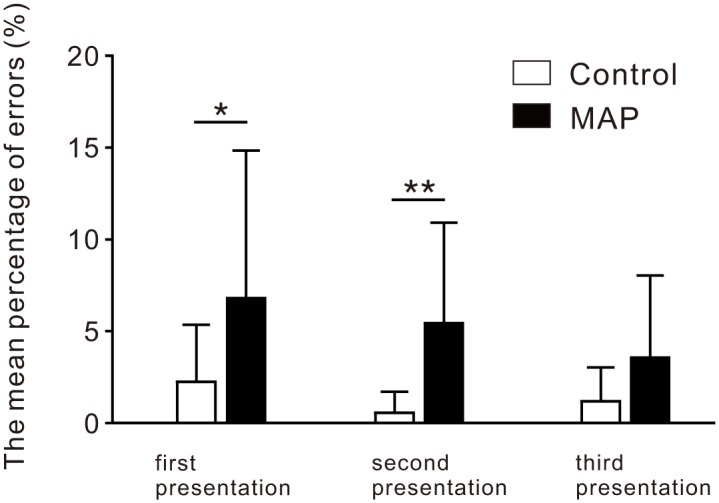
Mean percentage of errors during the incongruent Stroop color-word task.Comparison of mean percentage of errors between methamphetamine induced psychosis (MAP) and control groups during the incongruent Stroop color-word task. The black and open bars represent the MAP group and controls, respectively. *p<0.05, **p<0.01. Abbreviations: MAP, methamphetamine-induced psychosis.